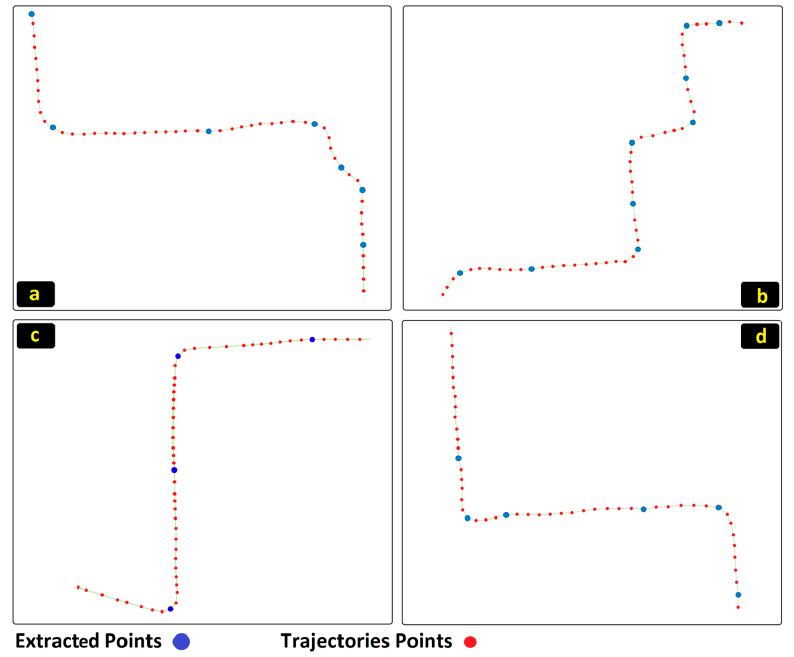
Figure 15. Detected trajectory turning and curvature points in different parts of some trajectories.